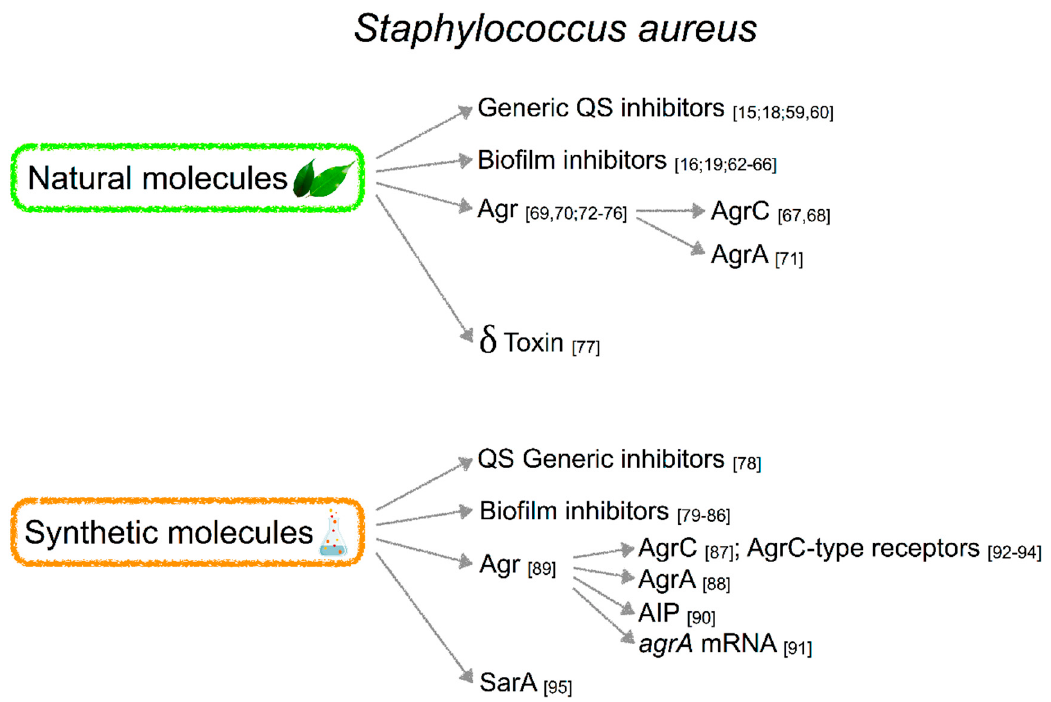
Figure 2. Targets of natural and synthetic molecules active against S. aureus quorum